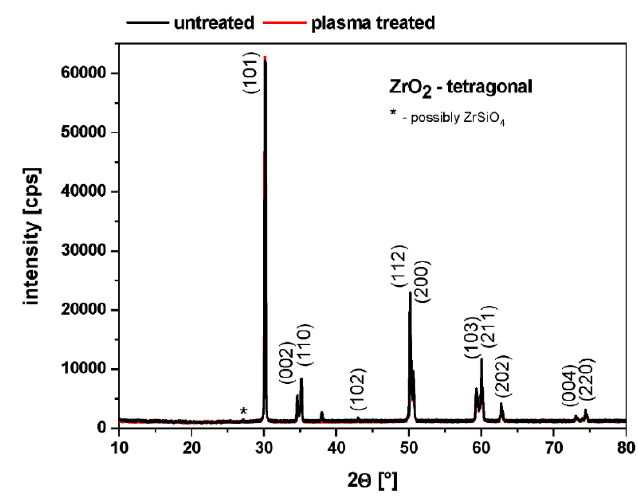
Figure 4. Grazing incidence X-ray diffraction (GIXRD) patterns of untreated and plasma polymerized allylamine (PPAAm) plasma-treated (960 s gross) tetragonal zirconia polycrystal (Y-TZP) ceramic.